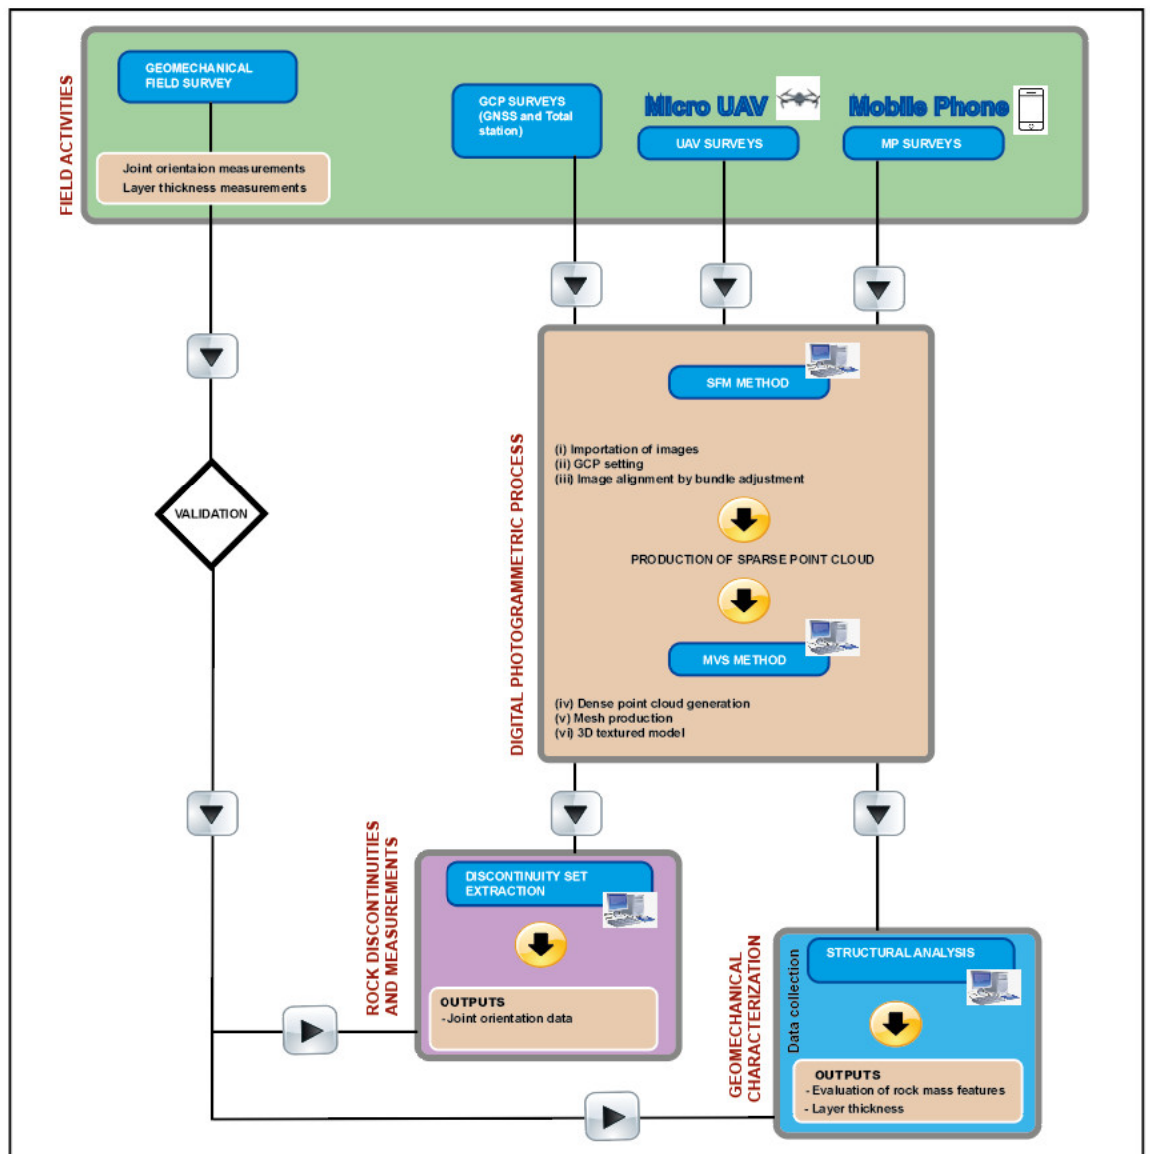
Figure 4. Workflow of the cliff investigation, including photogrammetric procedures.